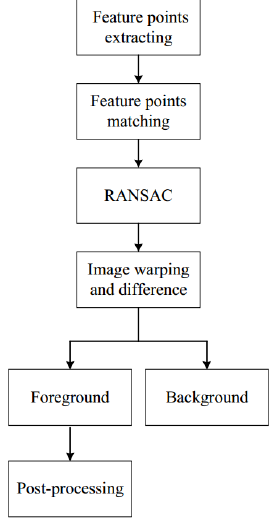
Figure 3. Moving background detector. SURF feature points are extracted firstly, which are used to match two frames. RANSAC algorithm is employed to estimate the transformation between the two frames. After that, we transform the camera coordinates of adjacent frames to a reference coordinate system. Then, image difference method is used to extract foreground. The final results are processed by morphological